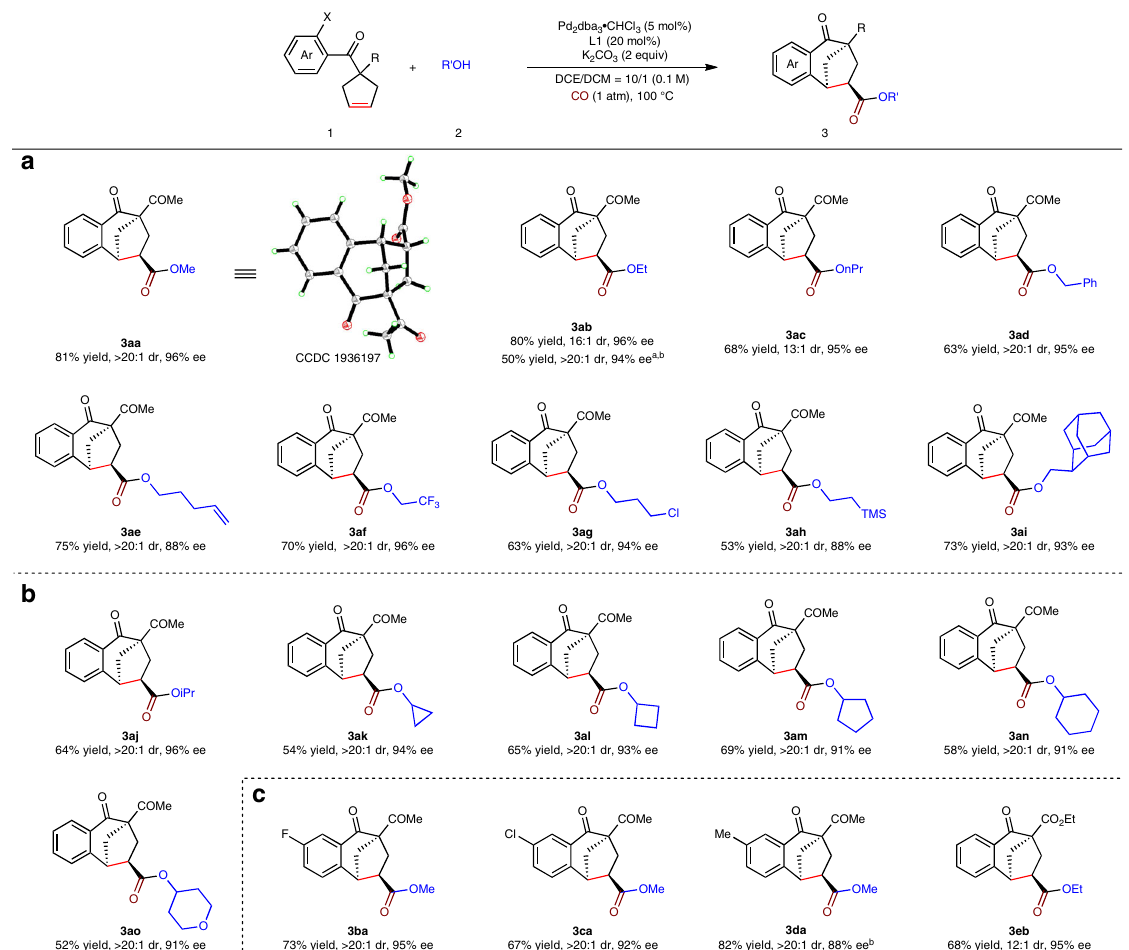
Fig. 2 Substrate scope. a Substrate scope of primary alcohols. b Substrate scope of secondary alcohols. c Substrate scope of the benzoylcyclopentenes. Reaction conditions: X = I, 1 (0.1 mmol), 2 (1 mmol), Pd 2 dba 3 • CHCl 3 (5 mol%), L1 (20 mol%), K 2 CO 3 (0.2 mmol) in 1 mL solvent, 100 °C, 36 h, under CO (1 atm). Yields of isolated products are given. The dr values were determined by 1 H NMR analysis. The ee values were determined by HPLC analysis on a chiral stationary phase. a X = Br. b 48